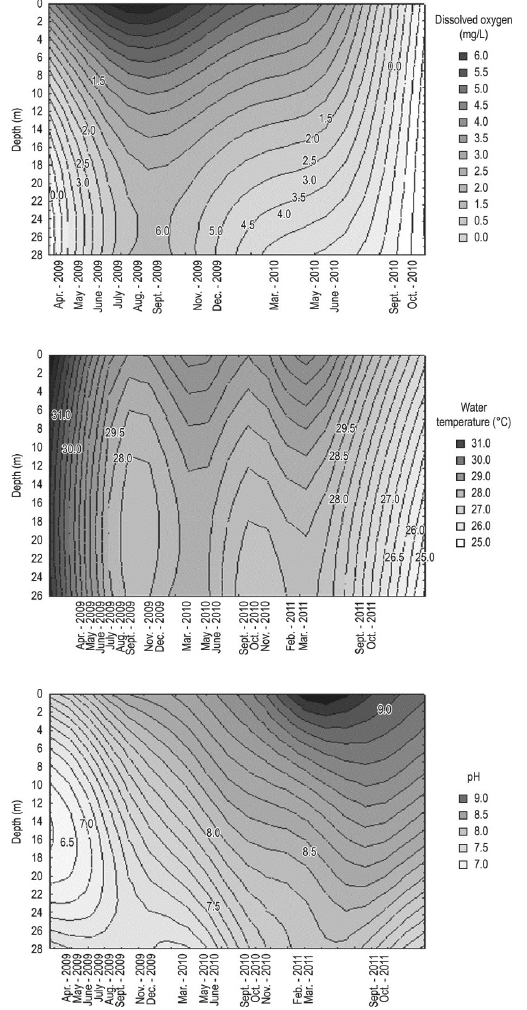
Figure 3. Diagram of depth and time isoclines of dis- solved oxygen (mg.L¯¹), water temperature (°C) and pH at point 1 at Armando Ribeiro Gonçalves Reservoir.